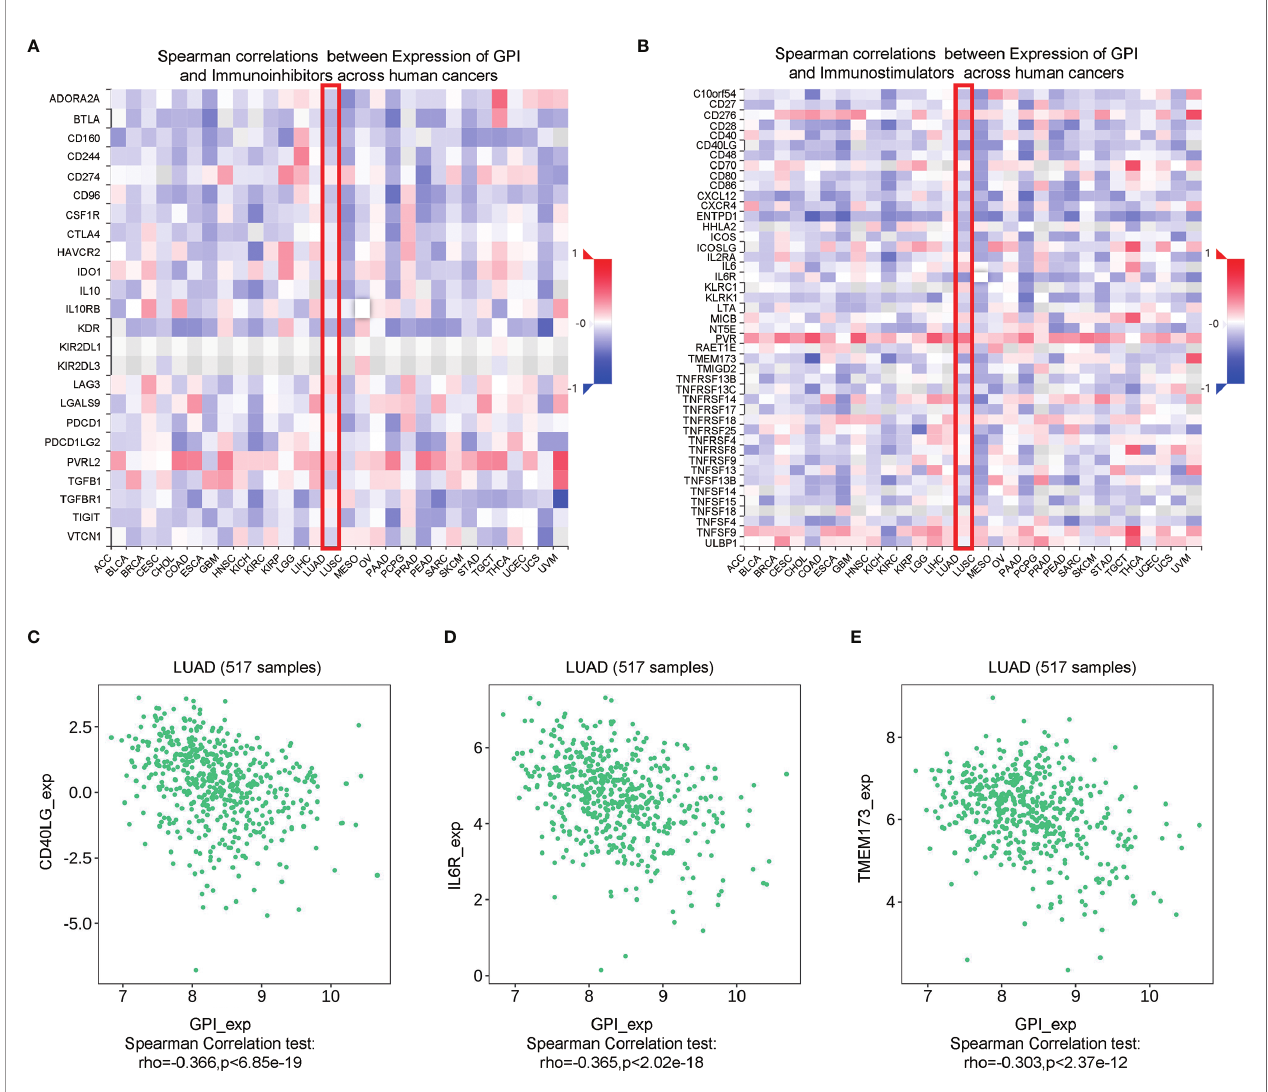
FIGURE 13 | Correlation analysis between glucose-6-phosphate isomerase (GPI) expression and immunoinhibitors and immunostimulators. (A) Correlation between GPI and immunoinhibitors in tumors by heatmap analysis. (B) Correlation between GPI and immunostimulators in tumors by heatmap analysis. (C – E) GPI expression is negatively correlated with the immunostimulators CD40L, IL6R, and TMEM173 in lung adenocarcinoma